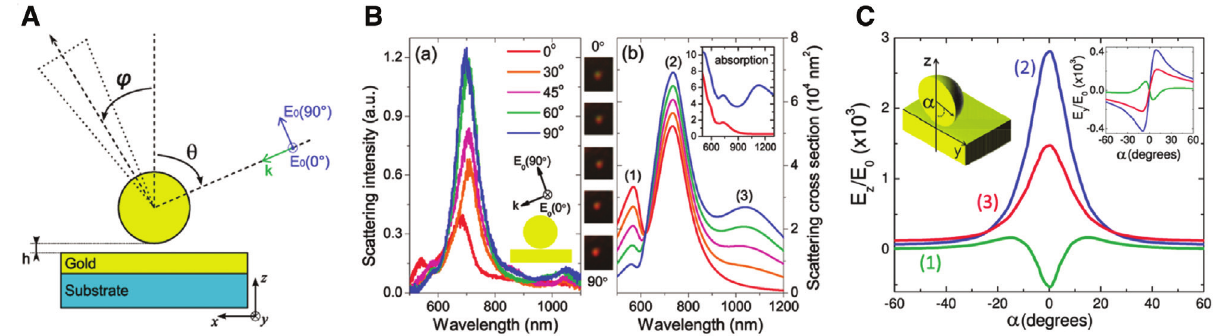
Figure 15: (A) System under investigation in [37], where a gold nanosphere is separated by a gap of size h from a gold film. Both the excita- tion and the collection are angle-dependent; (B) comparison between the experimental and simulated scattering spectra as a function of the polarization angle, together with the far-field image (dark-field spectroscopy) of the light scattered by one nanosphere; (C) distribution of the z- and y-component of the electric field around the nanosphere surface for the three modes labeled in (B). Reprinted with permission from ACS Nano, 2012, 6 (2), pp 1380–1386. Copyright 2012 American Chemical